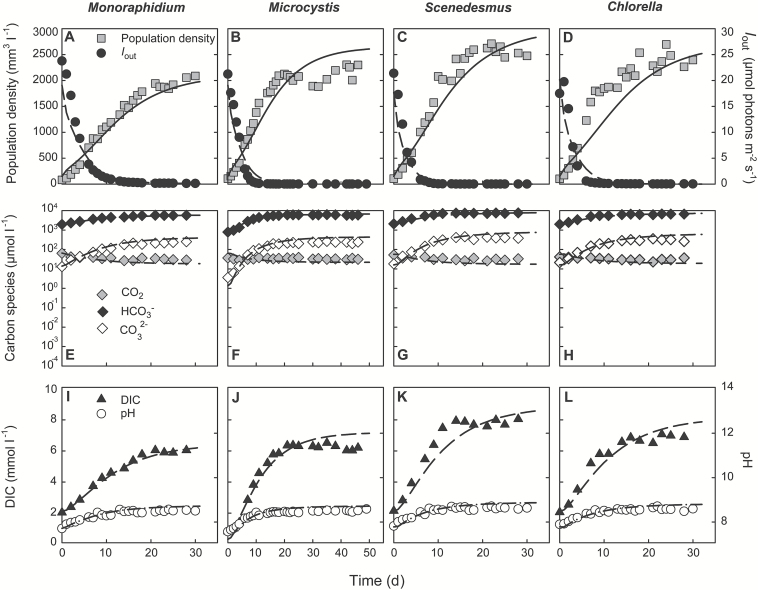
Monoculture experiments at high pCO2 (2000 ppm). (A–D) Population density (expressed as biovolume) and light intensity Iout penetrating through the chemostat. (E–H) CO2(aq), bicarbonate and carbonate concentrations. (I–L) Dissolved inorganic carbon (DIC) and pH. Different panels represent different species: (A, E, I) Monoraphidium; (B, F, J) Microcystis; (C, G, K) Scenedesmus; (D, H, L) Chlorella. Symbols indicate experimental data, and lines indicate model fits. Parameter values of the model are provided in Table 1 and Table 2.